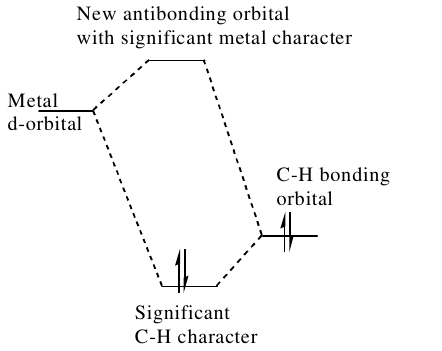
Figure 3 . Simplified molecular orbitals representation for the [M]…C2-H1